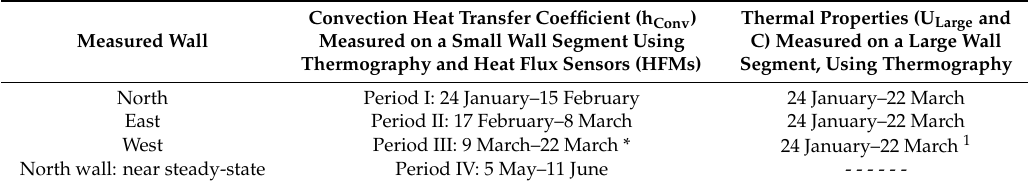
Table 1. Measurement periods of the small and large wall segments, as illustrated in Figure